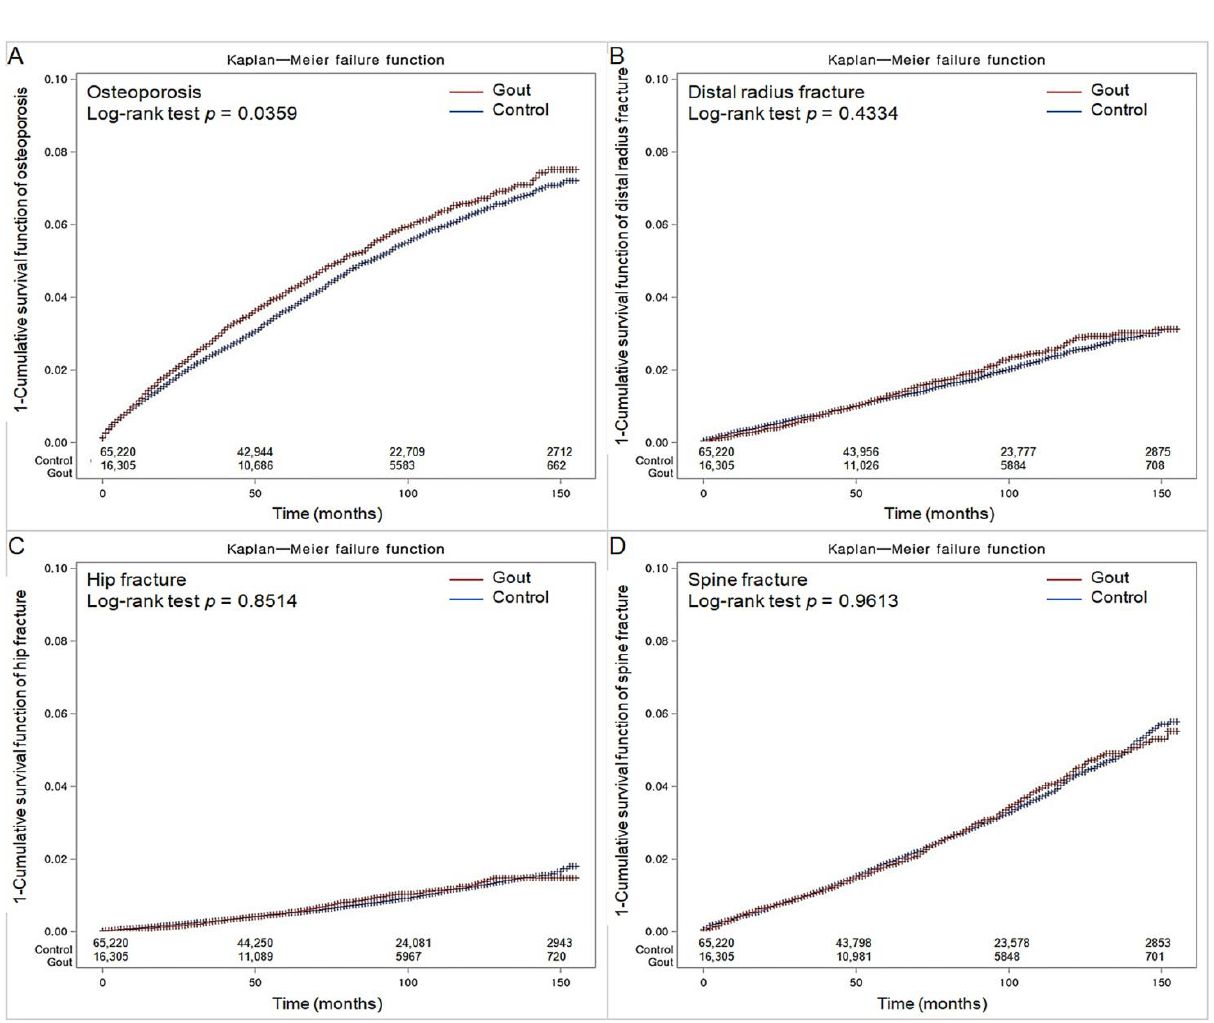
Table 3. Hazard ratio (95% confidence interval) for distal radius fracture in the gout and control groups with subgroup analyses according to age and sex.